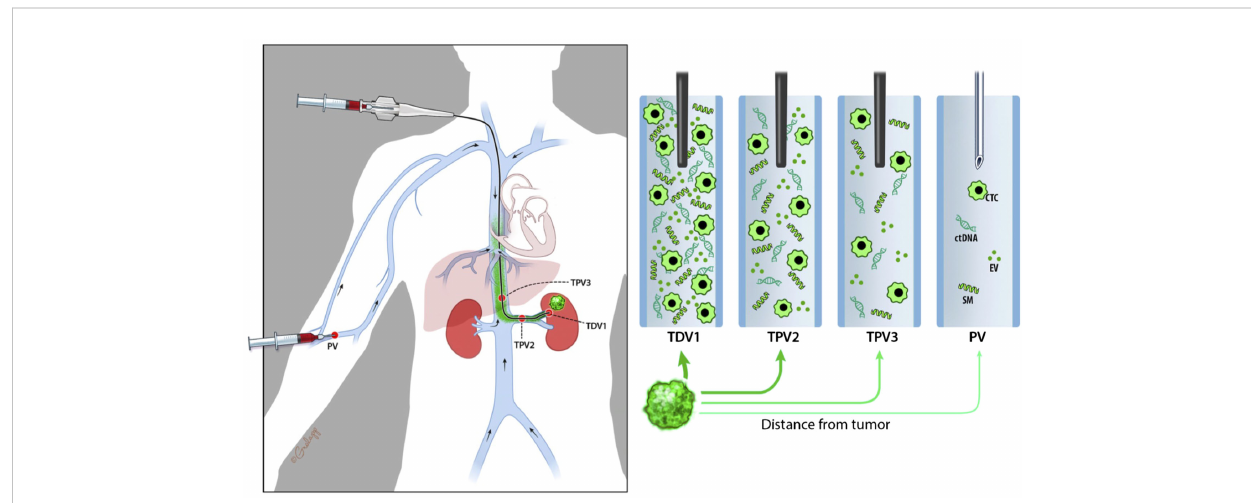
FIGURE 1 Schematic diagram representing nomenclature of tumor-draining and tumor-proximal veins and dilution in biomarker signal (in green) when sampled away from the tumor (green mass in the left kidney). Whole-body view is in the left panel and signal dilution at different sampling stations is depicted in the right panels. We refer to the most proximal branch of a vein draining the tumor as the tumor-draining vein (TDV1), and then in ascending order as tumor-proximal vein (TPV) 2, 3, etc., the further away it is from the tumor. We hypothesize that biomarker signals would be the highest in the TDV1, followed by TPV2, then TPV3, and so